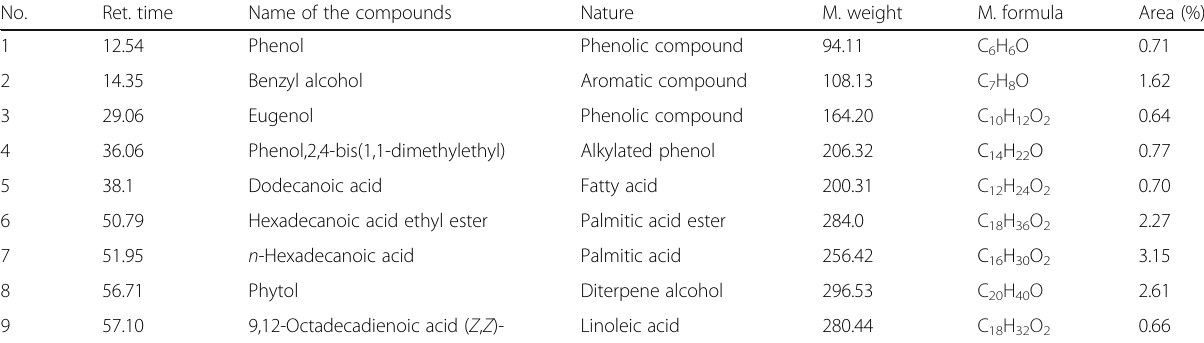
Table 1 Identified bioactive compounds in the methanol extract of C. nudiflora No. Ret. time